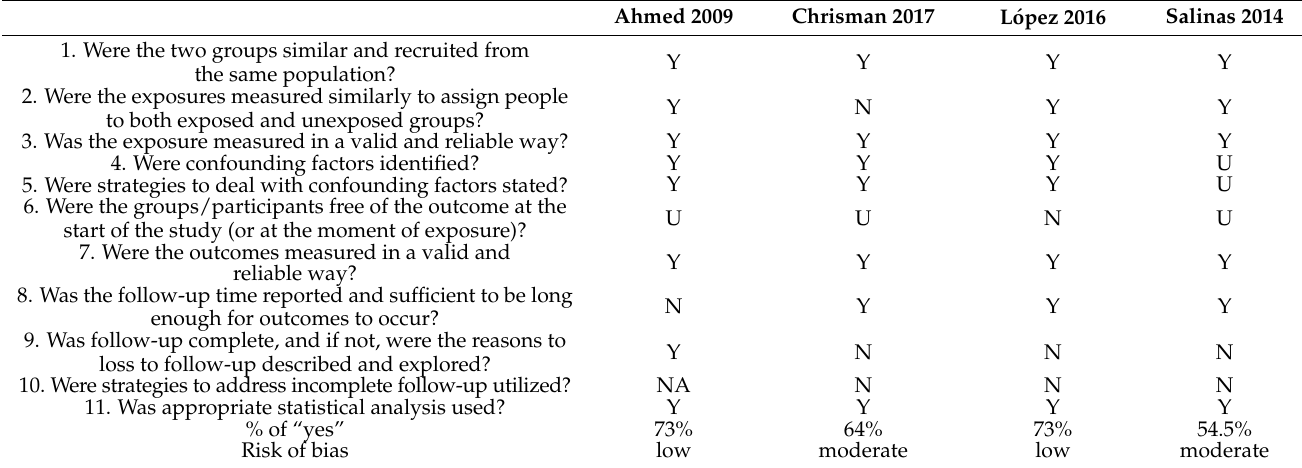
Table 4. JBI Critical Appraisal Checklist for Cohort Studies.